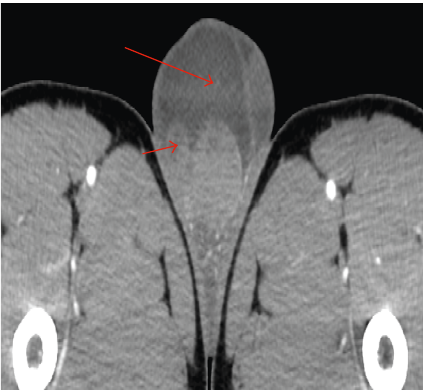
Figure 3: Bisected epididymis (E) and testicle (T), depicting a yellow-tan exudate and miliary deposits (arrows).